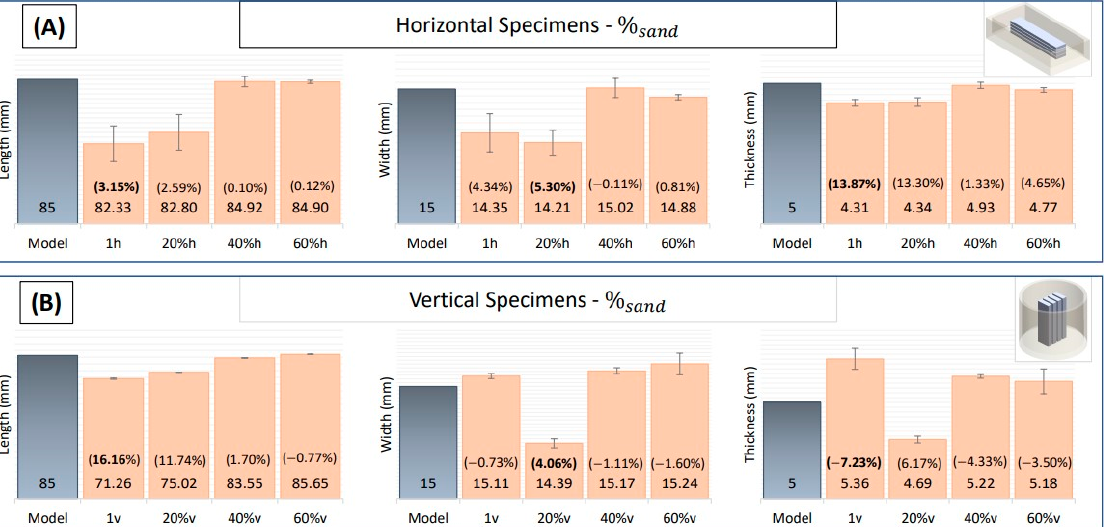
Figure 8. Average geometric distortion (shrinkage) of specimens with different sand percentage (% sand ). ( A ) Horizontally built specimens. ( B ) Vertically built specimens. Absolute values of each measure are in mm, and relative variation from CAD model is in percentage. Negative values indicate an increase in size. (Batches 1h and 1v are present in the graphs for comparison, as they contain specimens subject to the same sintering temperature and hold time but had 0% sand mixed in the build